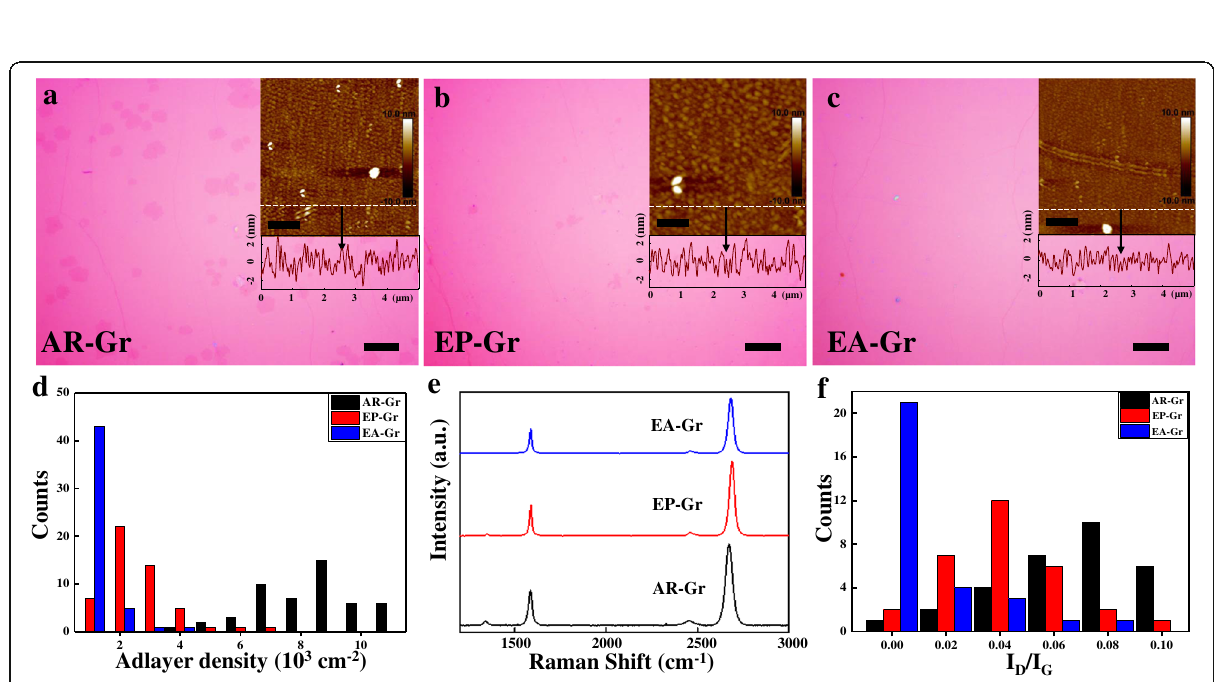
Fig. 3 OM images of graphene domains grown on a AR-Cu, b EP-Cu, and c EA-Cu, respectively. Scale bars, 10 μ m. d Histogram statistical graph of graphene domain density on AR-Cu, EP-Cu, and EA-Cu, respectively. The domain density is calculated by randomly taken a region with an area of 120 × 90 μ m 2 and then counting the domains within the